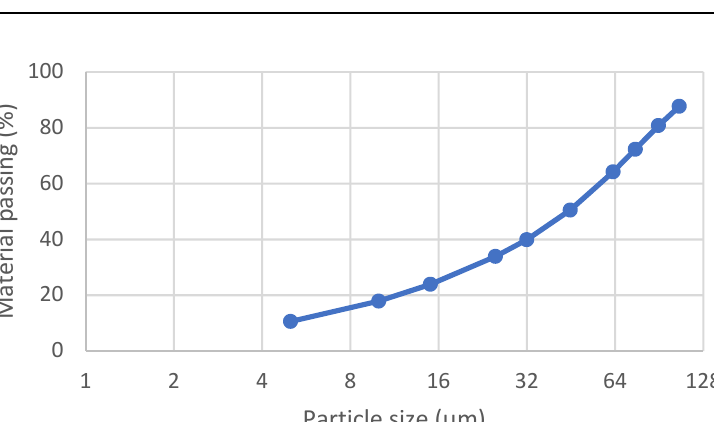
Table 2. Particle size distribution for the ground flotation feed.